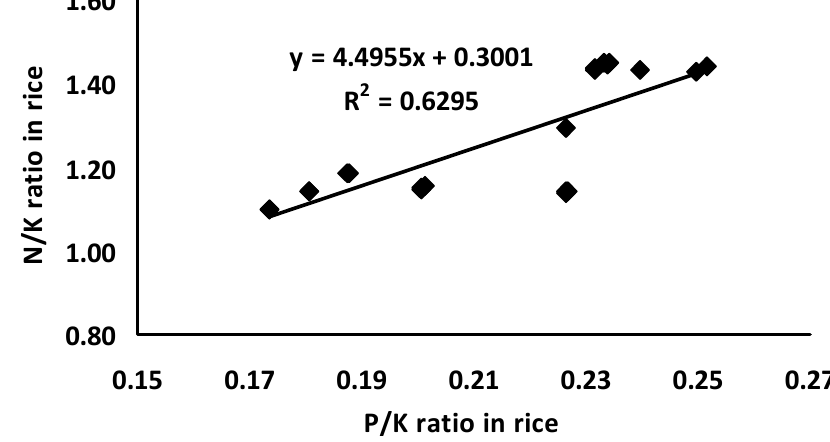
Figure 2. Relationship between the N/K and P/K ratios in rice plant.